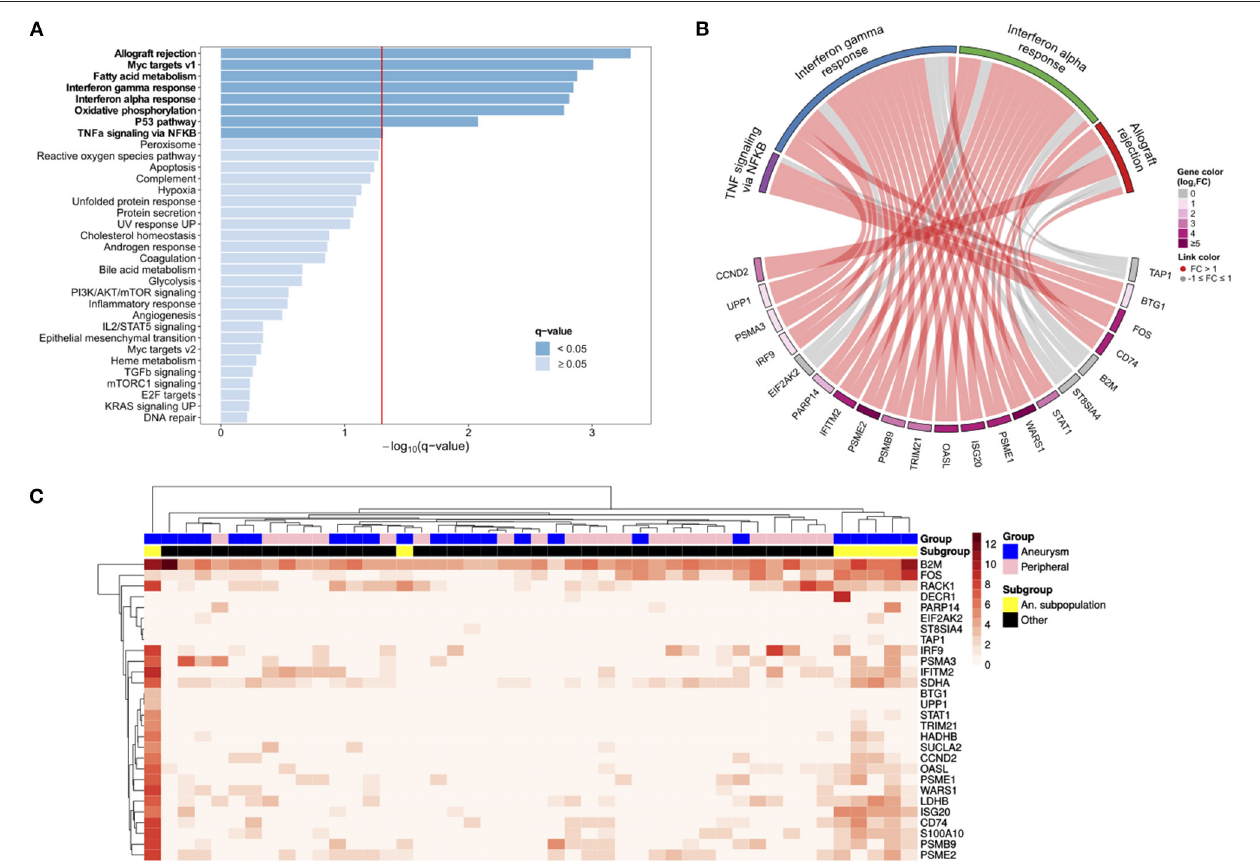
FIGURE 3 | The scRNAseq analysis identifies aneurysm endothelial cell subpopulation with the upregulated immunologic pathways. (A) A Gene set enrichment analysis (GSEA) of aneurysm EC subpopulation compared with the remaining ECs demonstrates the enrichment of hallmark pathways for allograft rejection, Myc targets, interferon γ and α response, oxidative phosphorylation, the p53 pathway, and tumor necrosis factor alpha (TNF α ) signaling via nuclear factor kappa-light-chain-enhancer of activated B (NF κ B) (bold = statistically significant). (B) A chord diagram constructed using the significantly enriched hallmark pathways demonstrates relationship between individual genes (bottom) with pathways (top). (C) A heatmap with the cells as columns and the genes as rows subjected to hierarchical clustering shows a subpopulation of aneurysm ECs (far right; yellow) in a distinct transcriptional state.